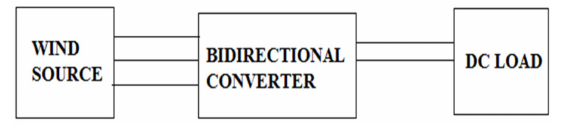
Figure 21. Block diagram of Case II.